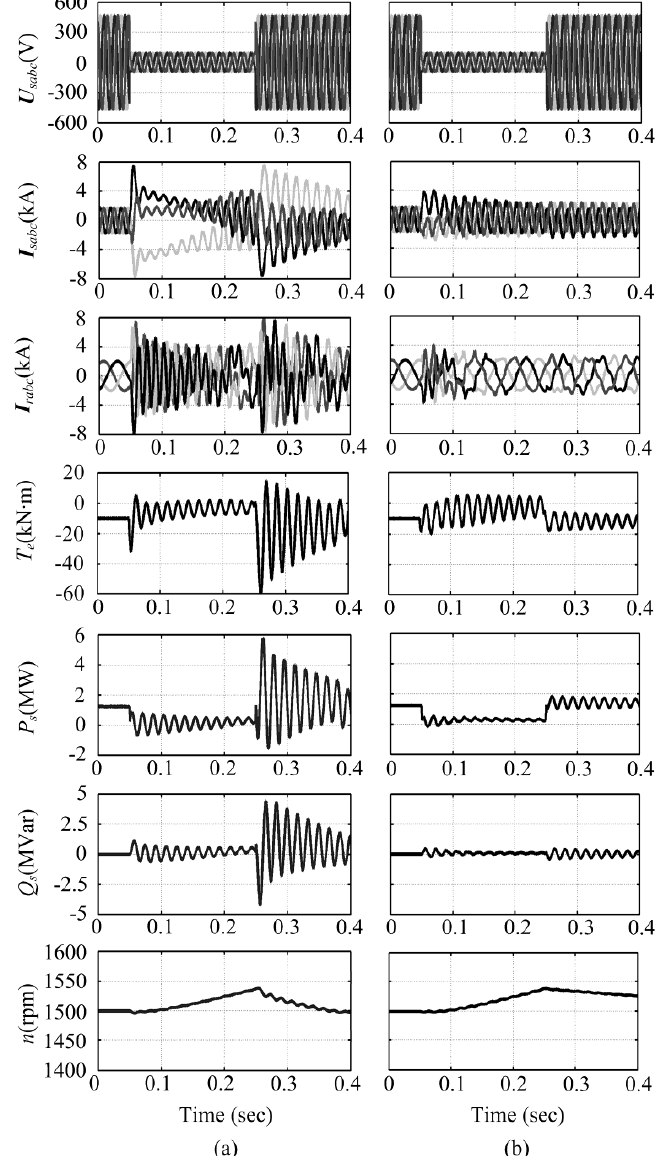
Figure 10. Simulation results on a DFIG when an 80% balance voltage drop occurs. ( a ) Conventional control; ( b ) Proposed